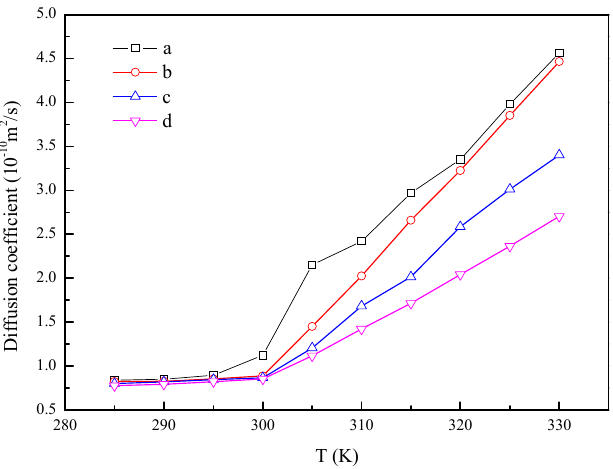
Figure 6. Diffusion coefficient of the different n -octadecane/Cu nanoparticle nanofluids with different system temperatures. ( a ) 128 n -octadecane molecules; ( b ) 1 Cu nanoparticle and 512 n -octadecane molecules; ( c ) 1 Cu nanoparticle and 256 n -octadecane molecules; ( d ) 1 Cu nanoparticle and 128 n -octadecane molecules.